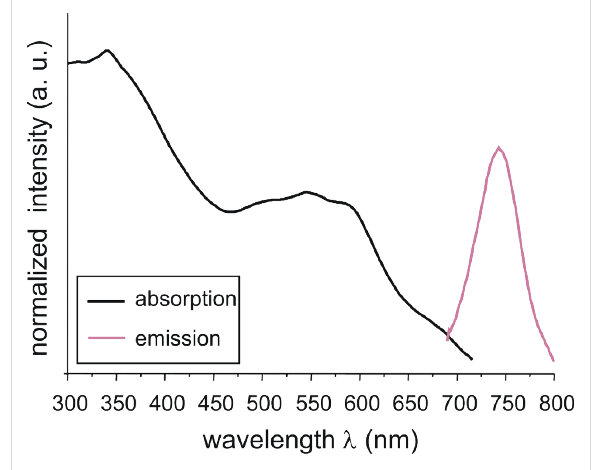
Figure 4: UV–vis absorption and emission diffuse reflectance spectra of sample 1-Si